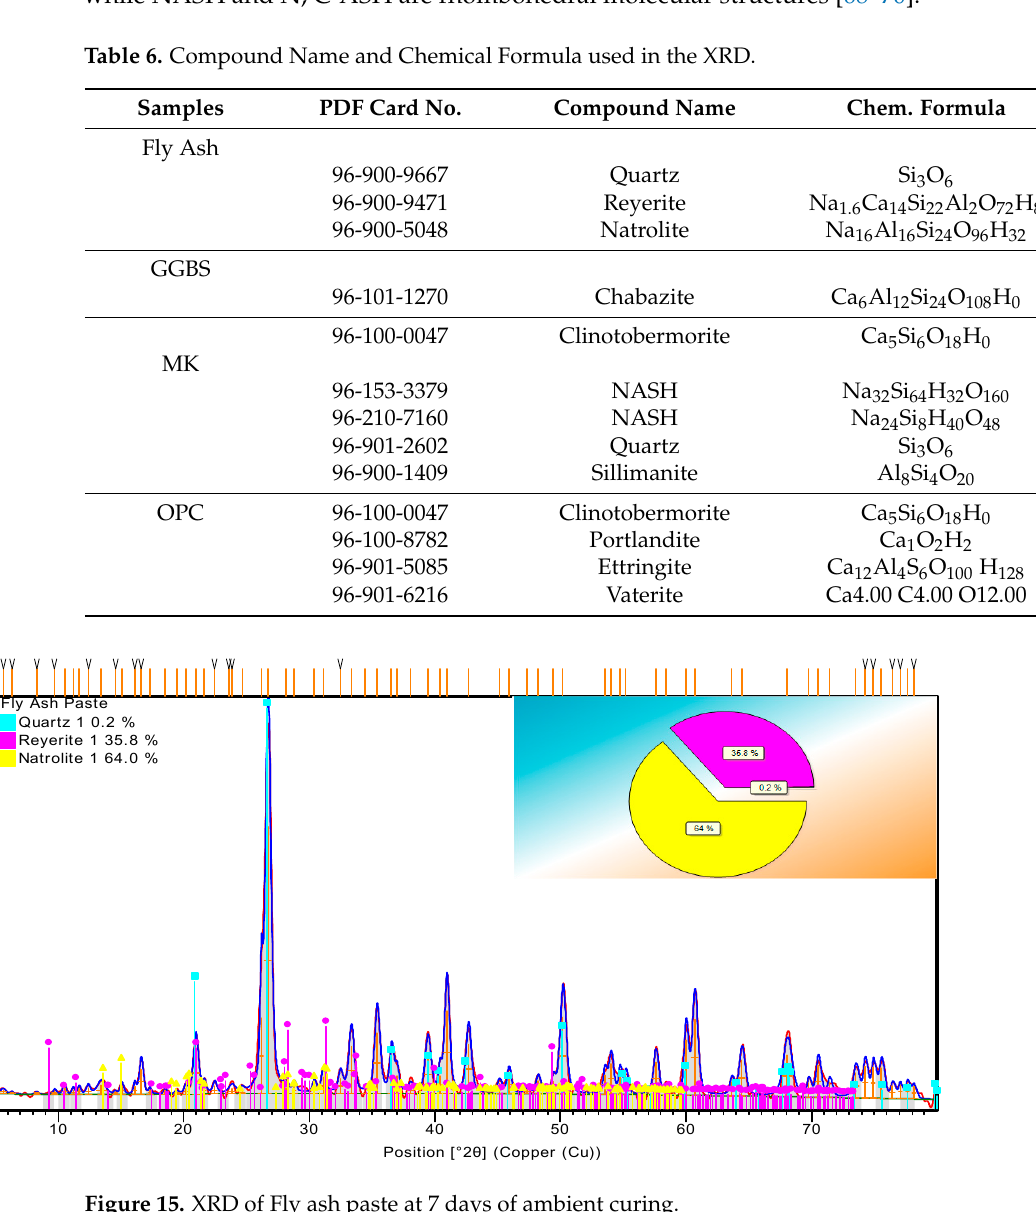
Figure 16. XRD of GGBS paste at 7th days of ambient-curing. Figure 17. XRD of Metakaolin paste at 7 days of ambient curing.